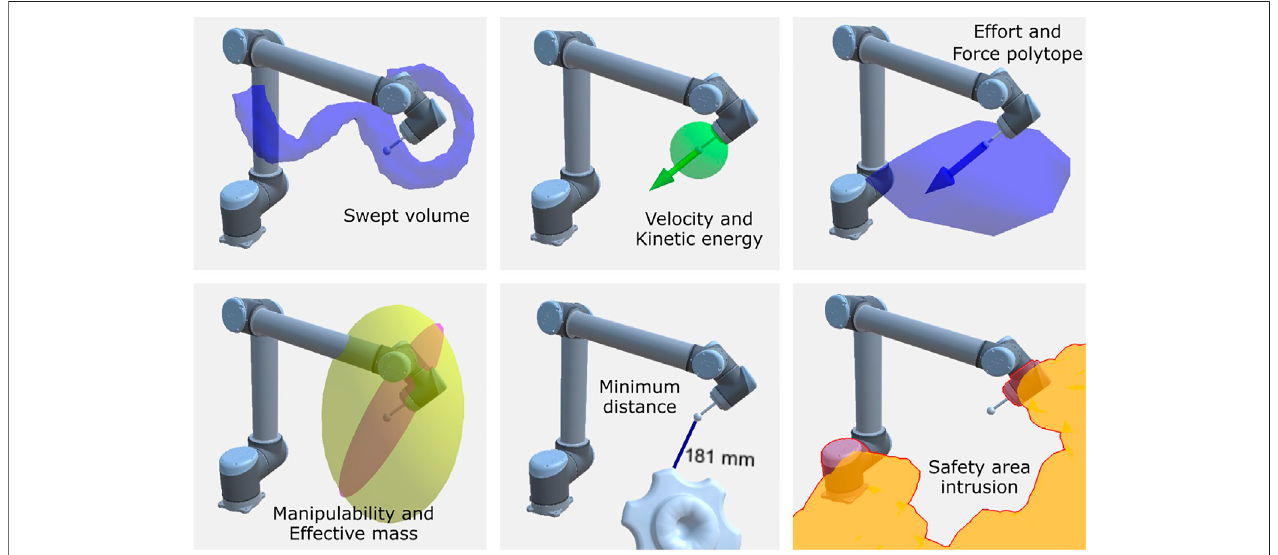
FIGURE 4 | Samples of safety criteria computed by the SEEROB framework. In the bottom left picture, the manipulability ellipsoid is represented in yellow and the effective mass in purple. In the bottom right picture, the robot links intruding in the yellow safety area are highlighted in red.